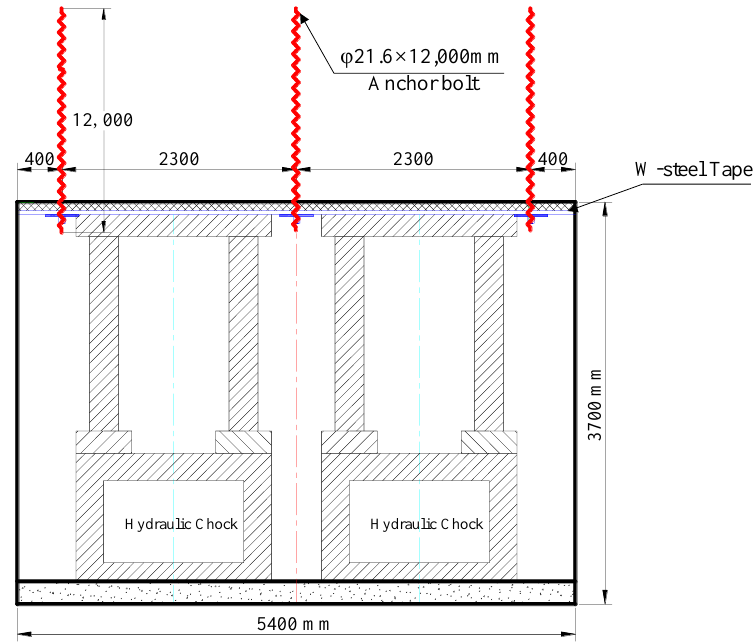
Figure 14. Schematic diagram of roof reinforcement and support of main retracement roadway. The auxiliary wall of the main retracement roadway is provided with support and secondary reinforcement. One group of the “ anchor cable + anchor bolt + steel tape ” com- bined support (shown in green in Figure 15) is built longitudinally and evenly spaced apart on the original support foundation. The main retracement roadway ’ s steel strip is 3.7 m long, with a row spacing of 2.4 m. The top three rows are anchor cable specifications, measuring φ1 7 × 87,000 mm with a 1000 mm spacing. The bottom row is deformed steel anchor bolts, which are specified as φ22 × 2400 mm, with a spacing of 1100 mm from the anchor cable (the purple part in Figure 15). The three resins are φ 23 mm × 600 mm, the additional anchor cable is a 300 mm × 300 mm × 16 mm tray, and the steel strip is specified as W230 × 3 mm. The anchor bolt and cable from the original support are shown in red in Figure 15 for the wall support for the main retracement roadway.